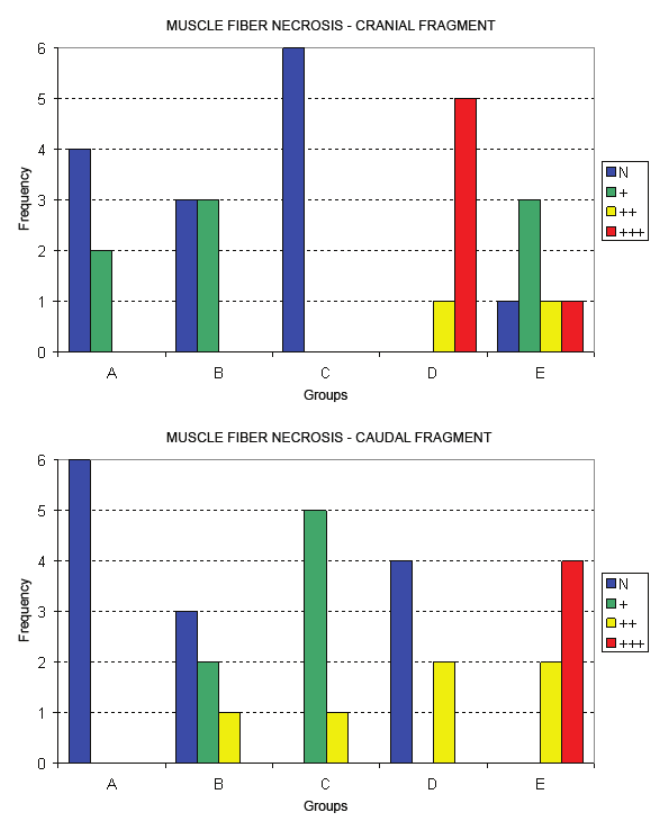
FIGURE 7 - Frequency and intensity of muscle fiber necrosis in groups A, B, C, D and